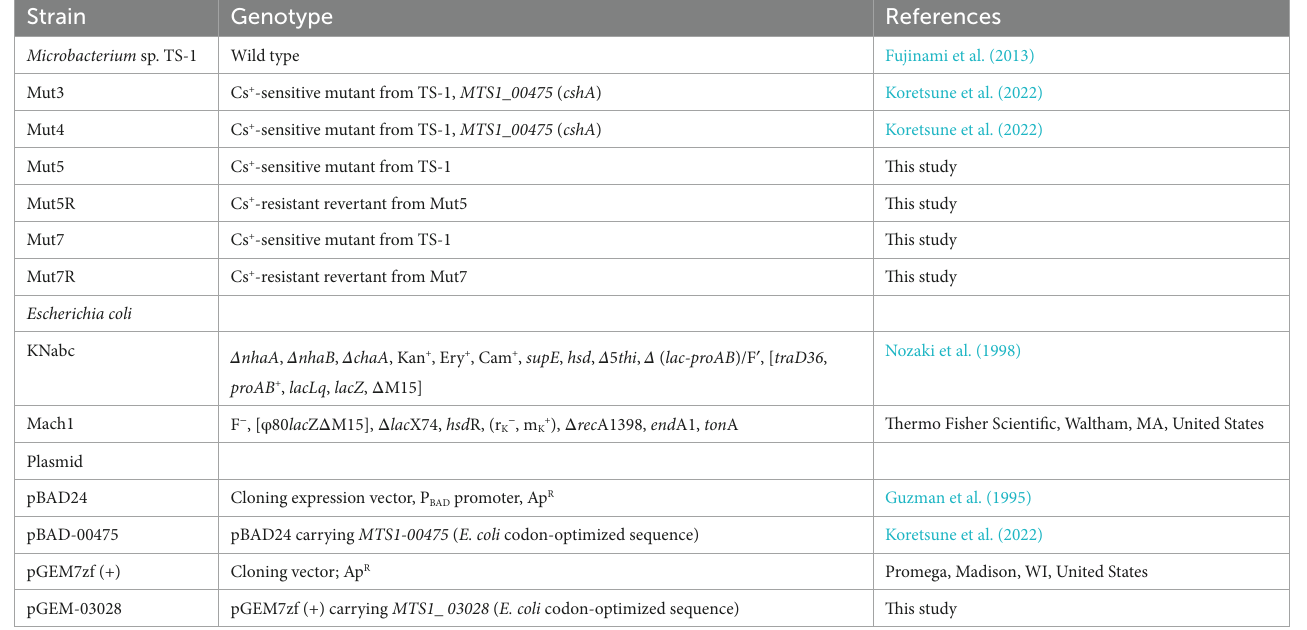
TABLE 1 Bacterial strains and plasmids used in the present study.